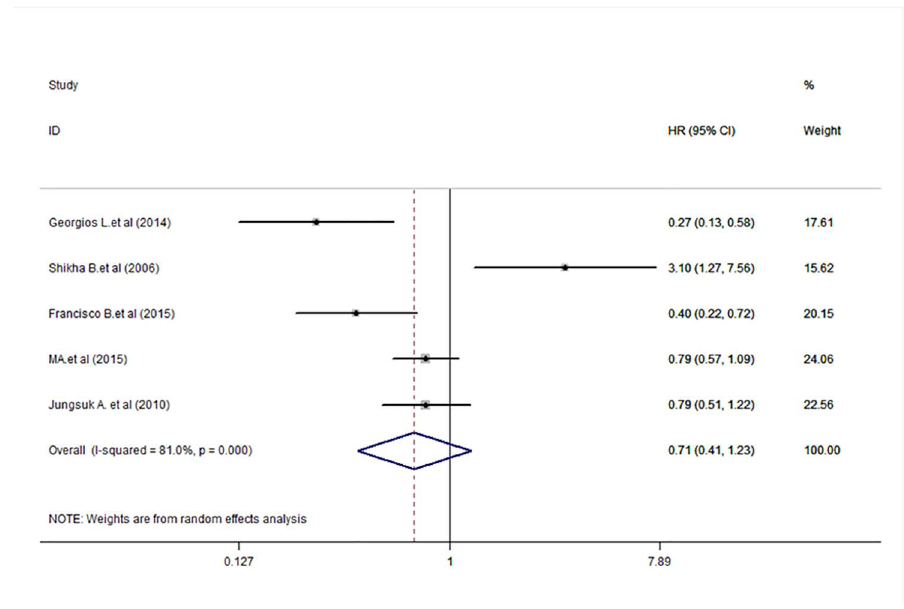
Fig 2. Meta-analysis of the overall pooled hazard ratios (HRs) of studies for the survival outcomes of breast cancer. Forest plot showingno statistical significanceof the associationbetweenp-mTOR expression and disease-free survival of breast cancer patients from the random-effects